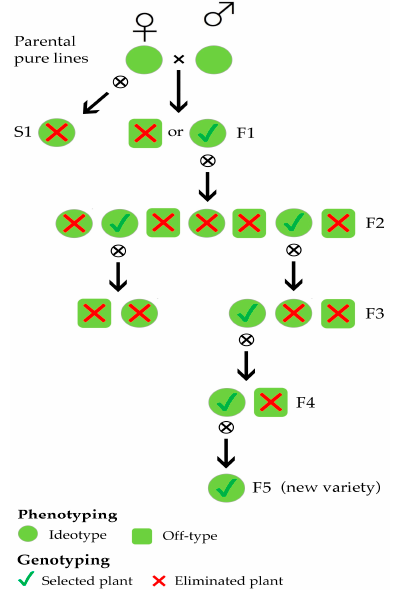
Figure 1. Simplified overview of a lettuce breeding scheme in which selection is based on both plant phenotyping and genotyping.